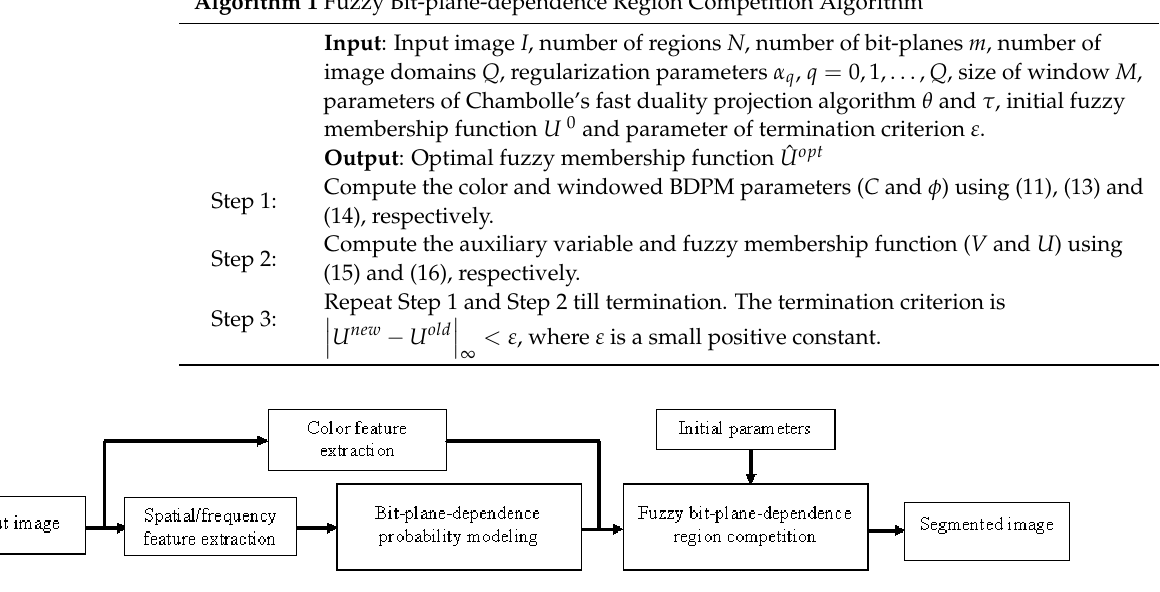
Algorithm 1 Fuzzy Bit-plane-dependence Region Competition Algorithm